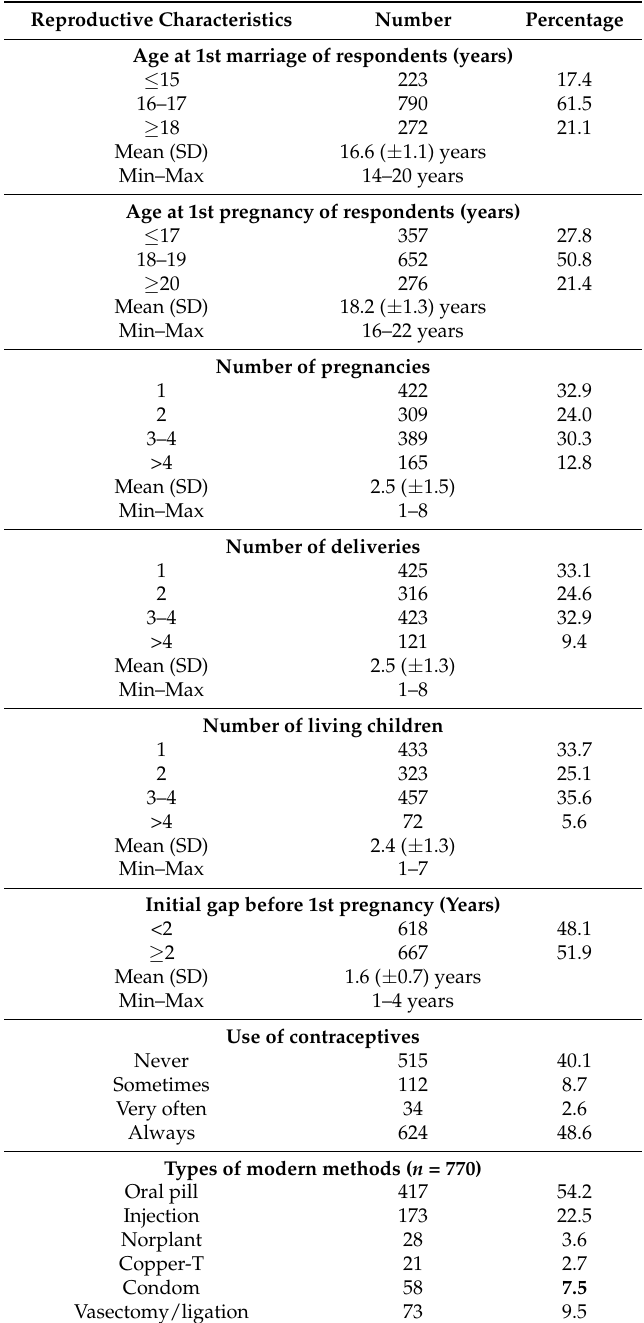
Table 3. Reproductive characteristics of respondents ( n =